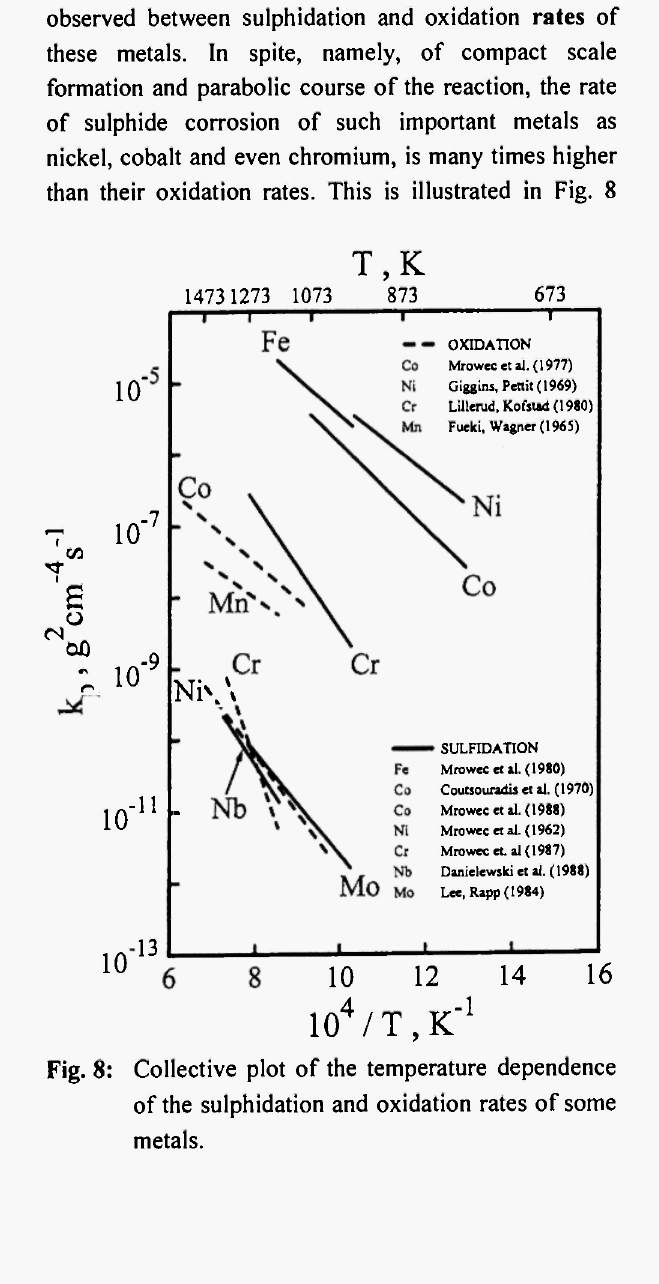
Fig. 8: Collective plot of the temperature dependence of the sulphidation and oxidation rates of some